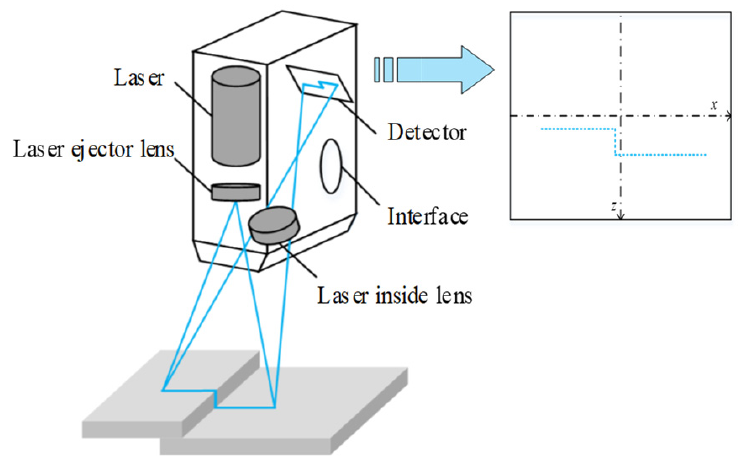
Figure 2. Schematic diagram of mechanism of single-line laser scanning system.